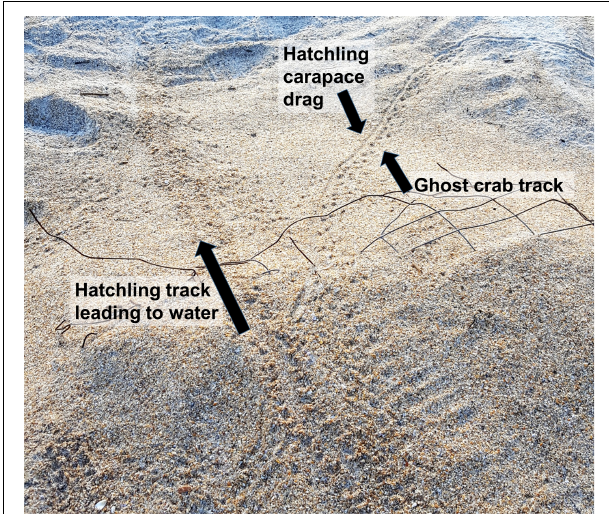
FIGURE 2 | The difference between a hatchling track leading to the ocean (Left) , and a hatchling track that was intercepted by a ghost crab (Right) . When a ghost crab took the hatchling, the turtle was dragged on its side so the carapace created a continuous line in the sand adjacent to the point-like tracks of the crab. The track details were still clearly visible the following morning. The interpretation of these tracks was confirmed by time-lapse infrared photography throughout the night.